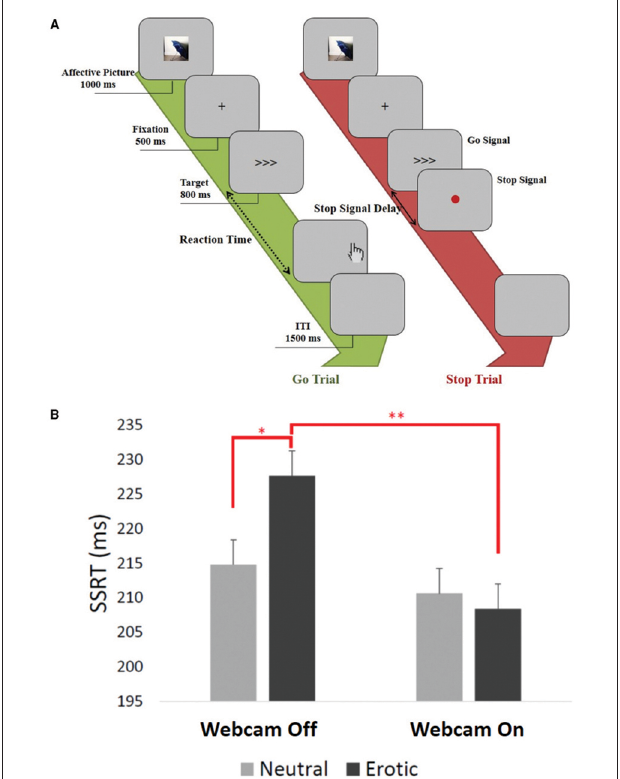
FIGURE 1 | (A) After an emotional stimulus, participants needed to do a speeded choice response task in which they were required to withhold response if a stop signal was presented. There were 144 go trials and 48 stop trials in each emotion condition. One erotic/neutral image was shown to participants shortly before each trial for 1 s. (B) Mean of stop-signal reaction times (SSRTs), with 95% confidence interval error bars. No difference was seen in SSRTs in the neutral condition ( F = 0.137, p = 0.715) but a significant difference in SSRTs in the erotic condition ( F = 8.540, p = 0.007) was seen between the two groups. * p < 0.05, ** p <